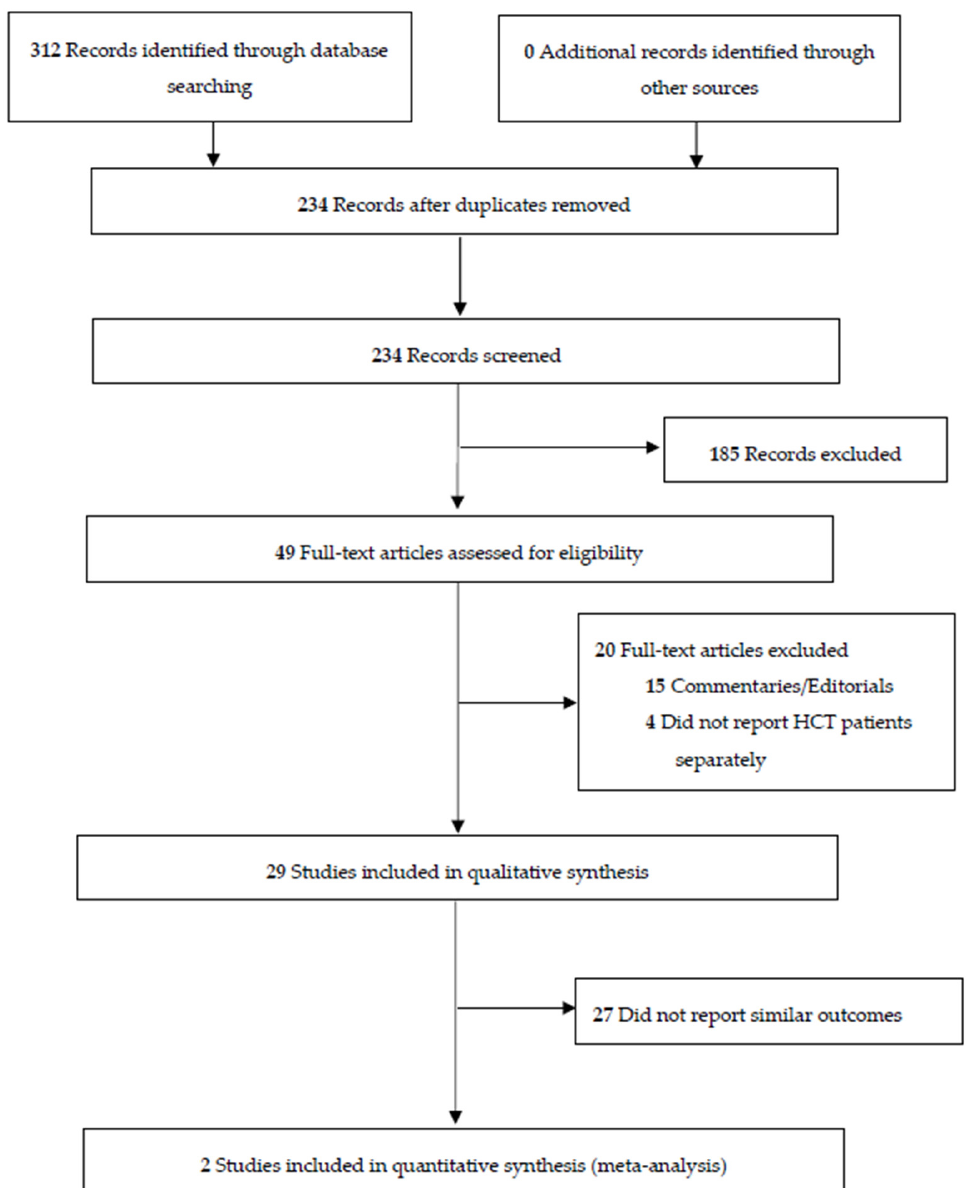
Figure 1. PRISMA flow diagram for the study selection process.